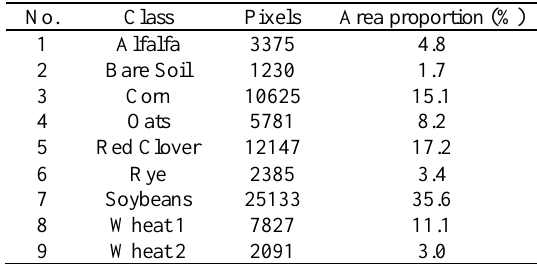
Table 1. Multispec test data set